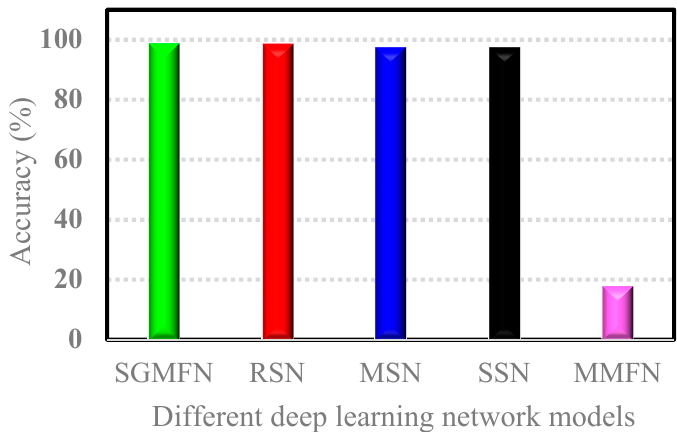
Figure 10. Comparison results of accuracy of different network models.